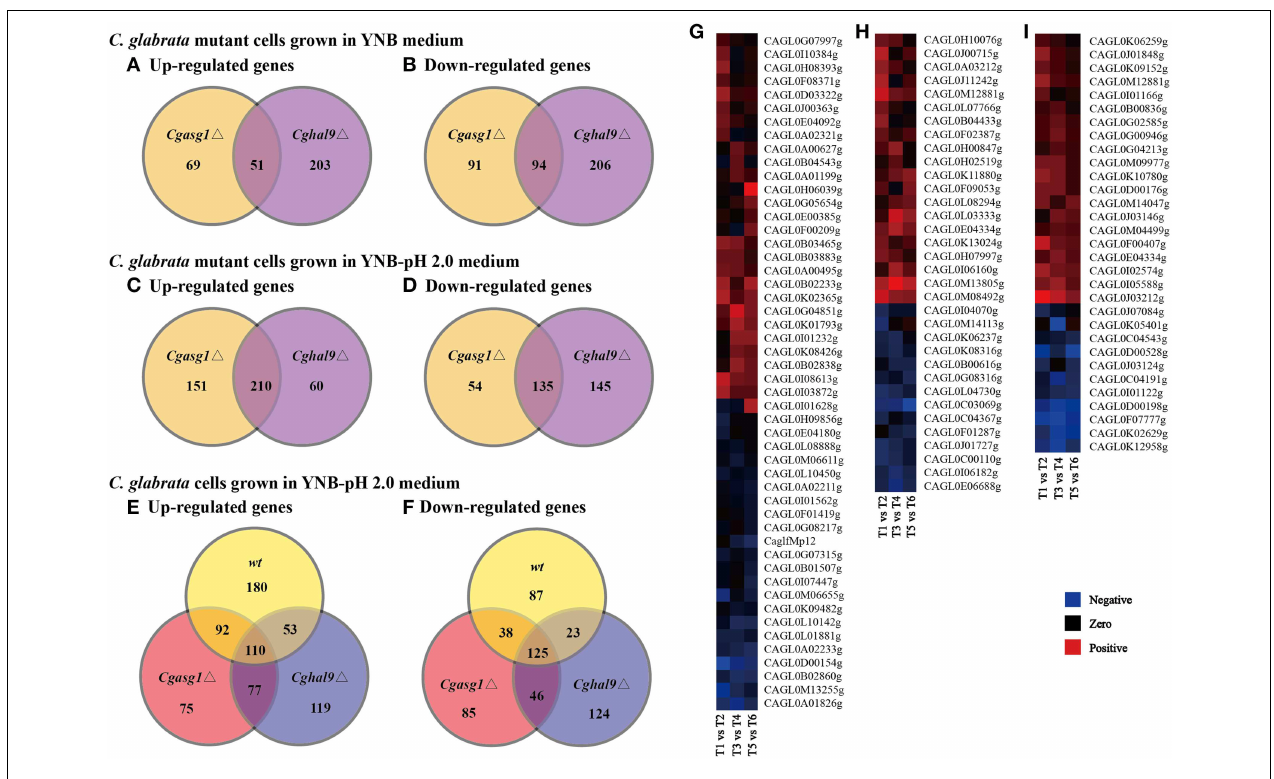
up-regulated (E) and down-regulated (F) genes in wild-type (T2), Cgasg1 1 (T4), and Cghal9 1 (T6) in YNB-pH 2.0 medium compared with the corresponding strains (T1, T3, T5) in YNB medium. Comparison of gene expression involved in cellular component of integral component of membrane (GO:0016021) (G) , cellular component of membrane (GO:0016020) (H), and oxidation-reduction process (GO:0055114) (I) in T2, T4, and T6 compared with T1, T3, and T5,